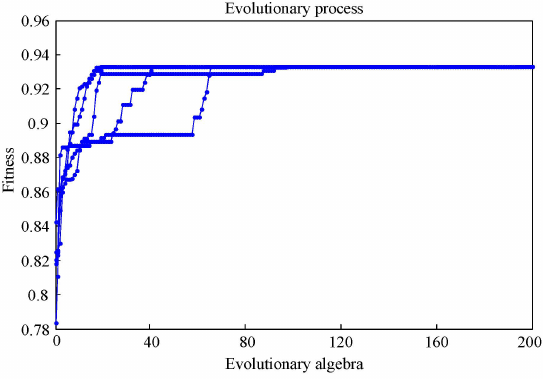
Figure 11. Convergence procedure of the MPGA under fault scenario 2.